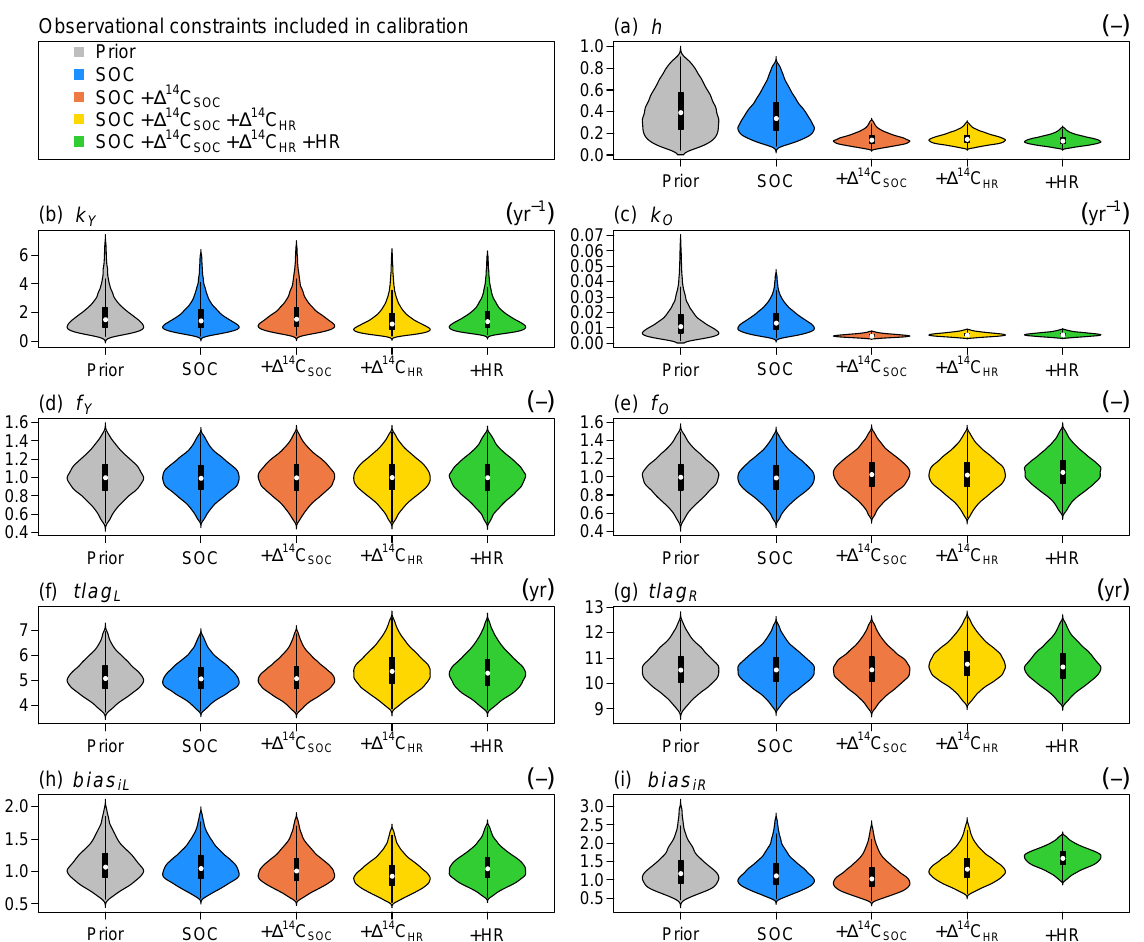
Fig. 4. Howland Tower. Violin plots of the posterior distributions of parameters using different combinations of observational constraints (legend). The first column shows the prior distribution of the parameter. The violins show a kernel density estimation of the prior and posterior. The white dots indicate the median of the parameter set, black boxes indicate the interquartile range (IQR) between the 25th and 75th percentile, the thin black lines indicate the upper and lower adjacent